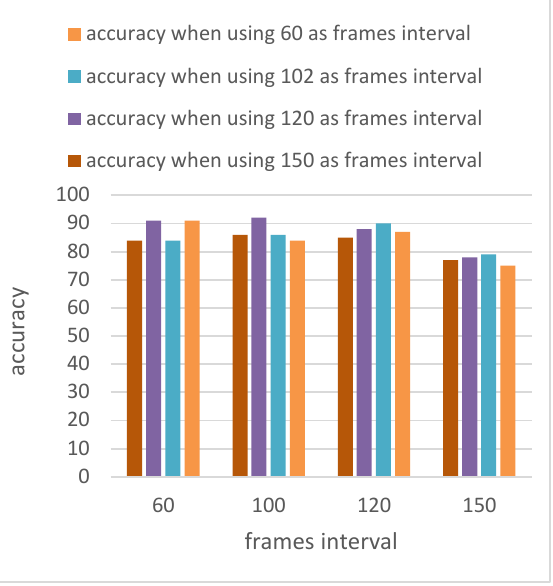
frames interval Figure 6. Accuracy for different frame interval, for making training set from second environment and test on the first environment.